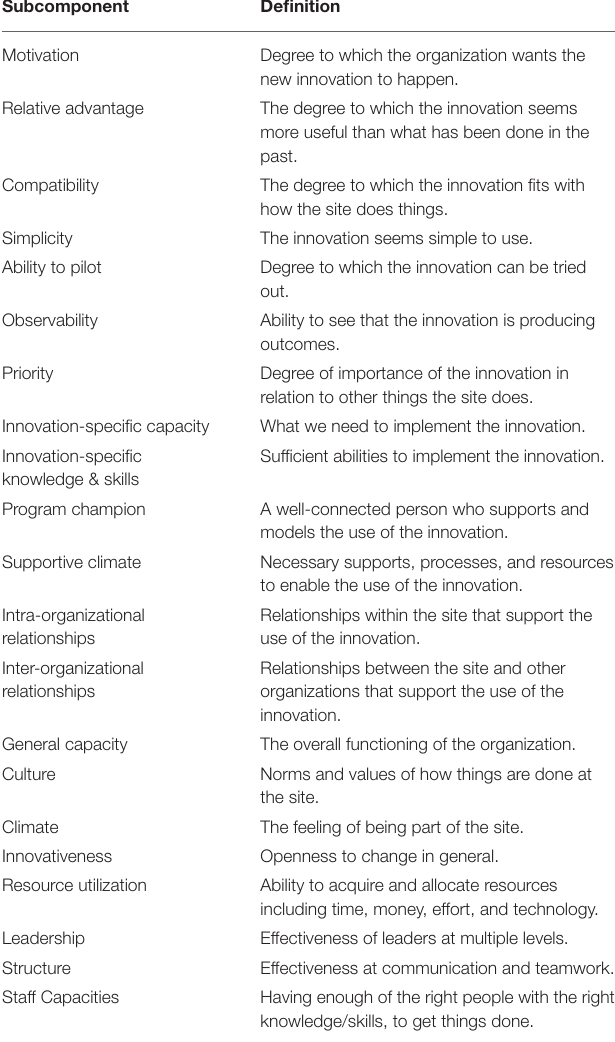
TABLE 2 | Readiness components and